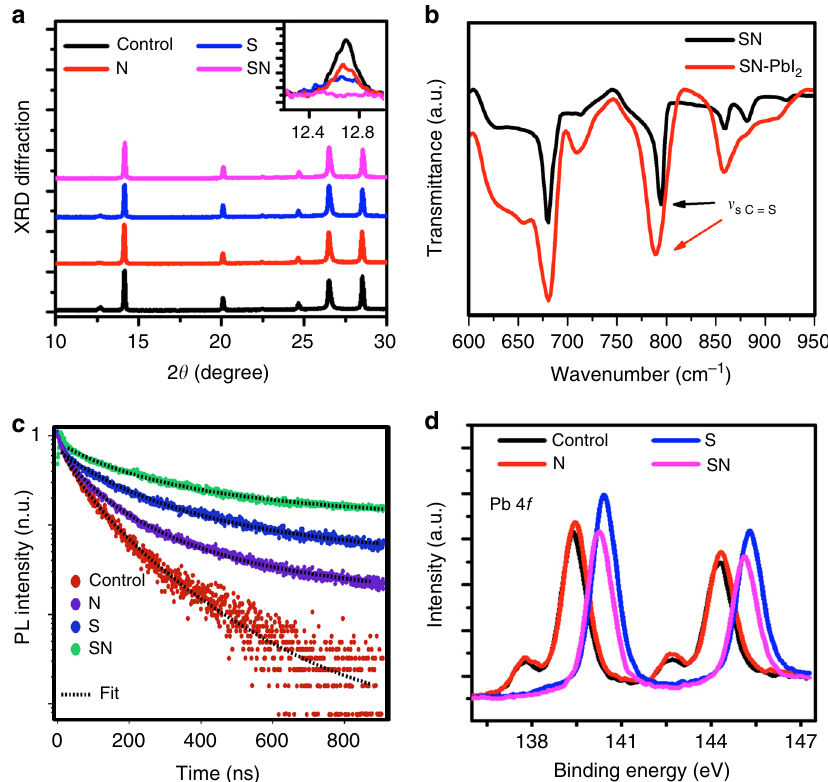
Fig. 2 Material characterization of perovskite fi lms. a XRD patterns. A peak at 12.5° that arises from the (001) lattice planes of hexagonal (2 H polytype) PbI 2 is shown in the inset. b Fourier transform infrared (FTIR) spectra. c Time-resolved photoluminescence measurements of the pristine (control) and modulator-containing (N, S, and SN) perovskite fi lms. The arrows in b indicate the stretching vibration peak of C = S in the fi lms, and the dashed lines in c show the fi ts of the experimental data to Eq. (3). d X-ray photoelectron spectroscopy of the perovskite fi lms in the absence (control) and presence of molecular modulators (N, S, and SN). The binding energies at approximately 138 eV and 142.5 eV in d denote the signals for Pb(II) species resulting from interfacial decomposition, such as PbO, whereas the predominant Pb 4 f signals can be ascribed to unsaturated Pb 2 + surface ions